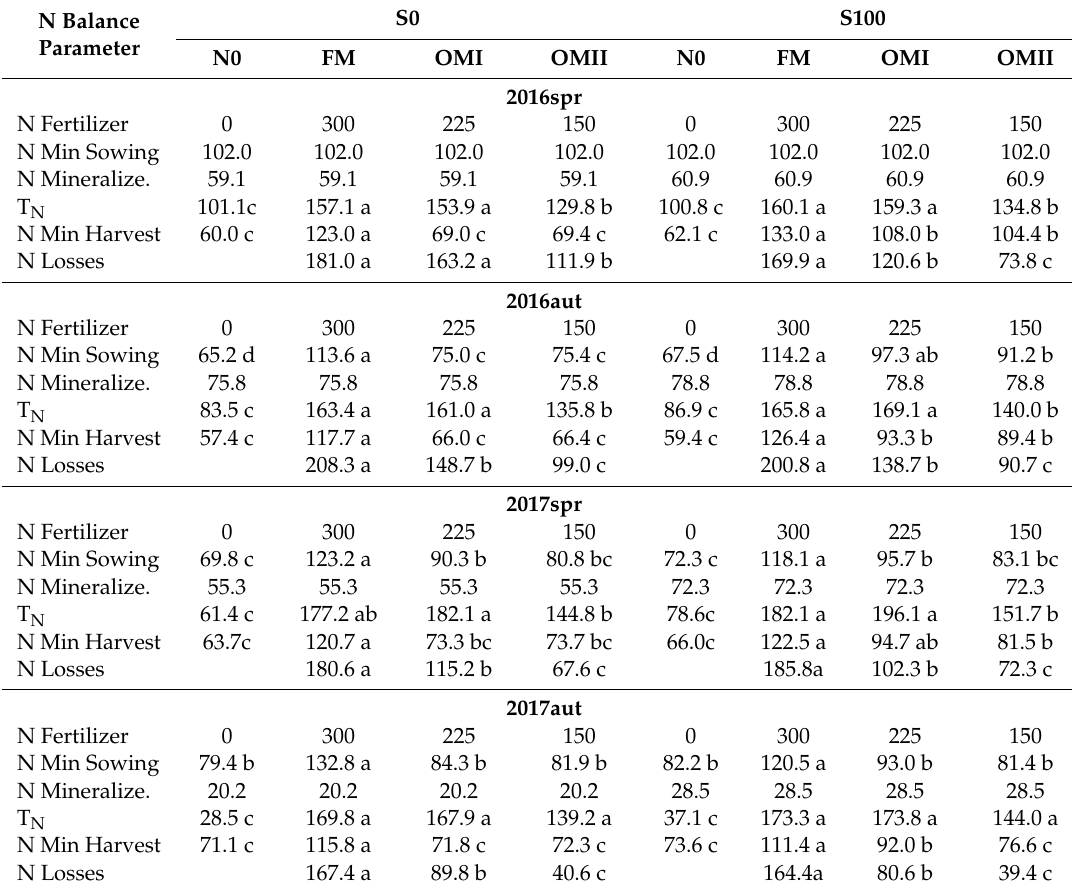
Table 8. Components of the N balance in the di ff erent treatments for the four growing seasons. N inputs: N applied with fertilizer (N fertilizer), soil mineral N before sowing 0–0.9 m (N min sowing), apparent N mineralization (N mineralize.); N outputs: total above-ground N uptake (T N ), soil mineral N